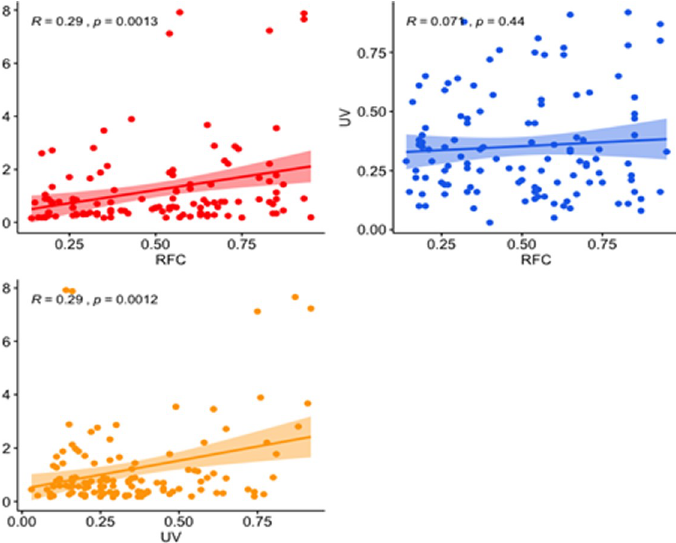
Fig 6. The scatter plot representing correlation for a) RFC vs SCI, b) UV vs RFC and c) CSI vs UV of the vegetation studied at Head Maralla.